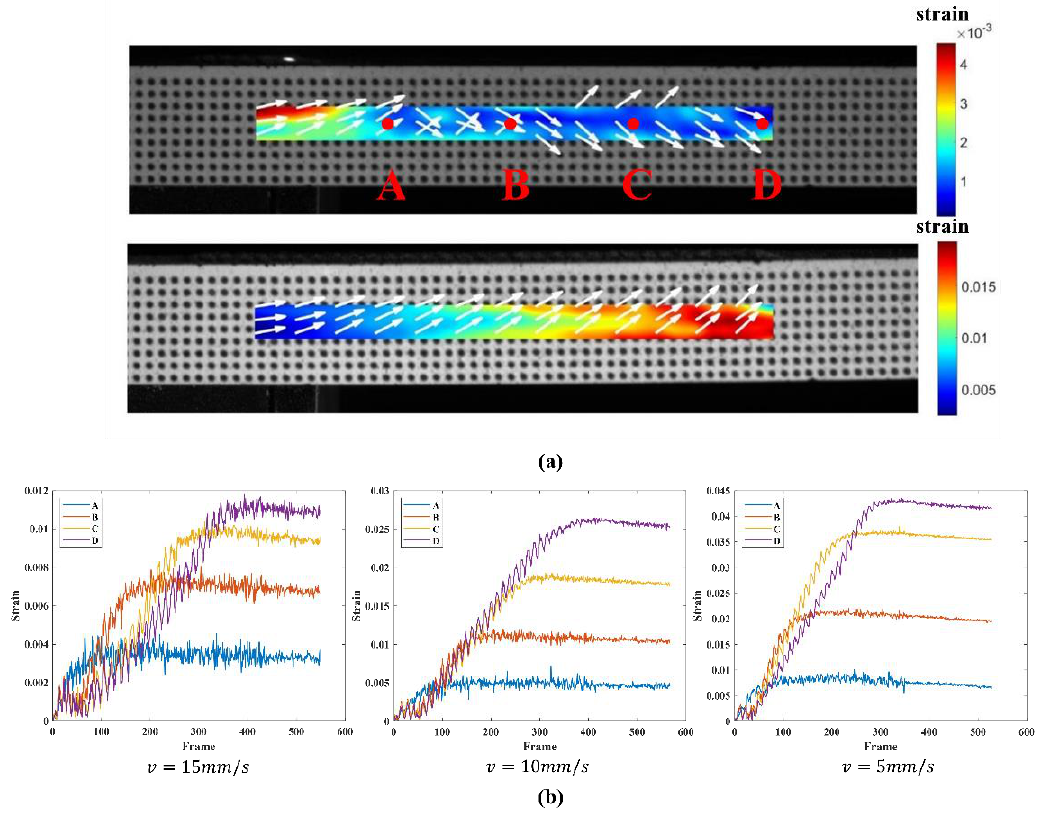
Figure 12. ( a ) Equivalent strain field at the beginning and the end of printing at 10 mm/s, A, B, C and D are the strain measurement points along x direction, ( b ) variation curve of an equivalent strain at four points with time.